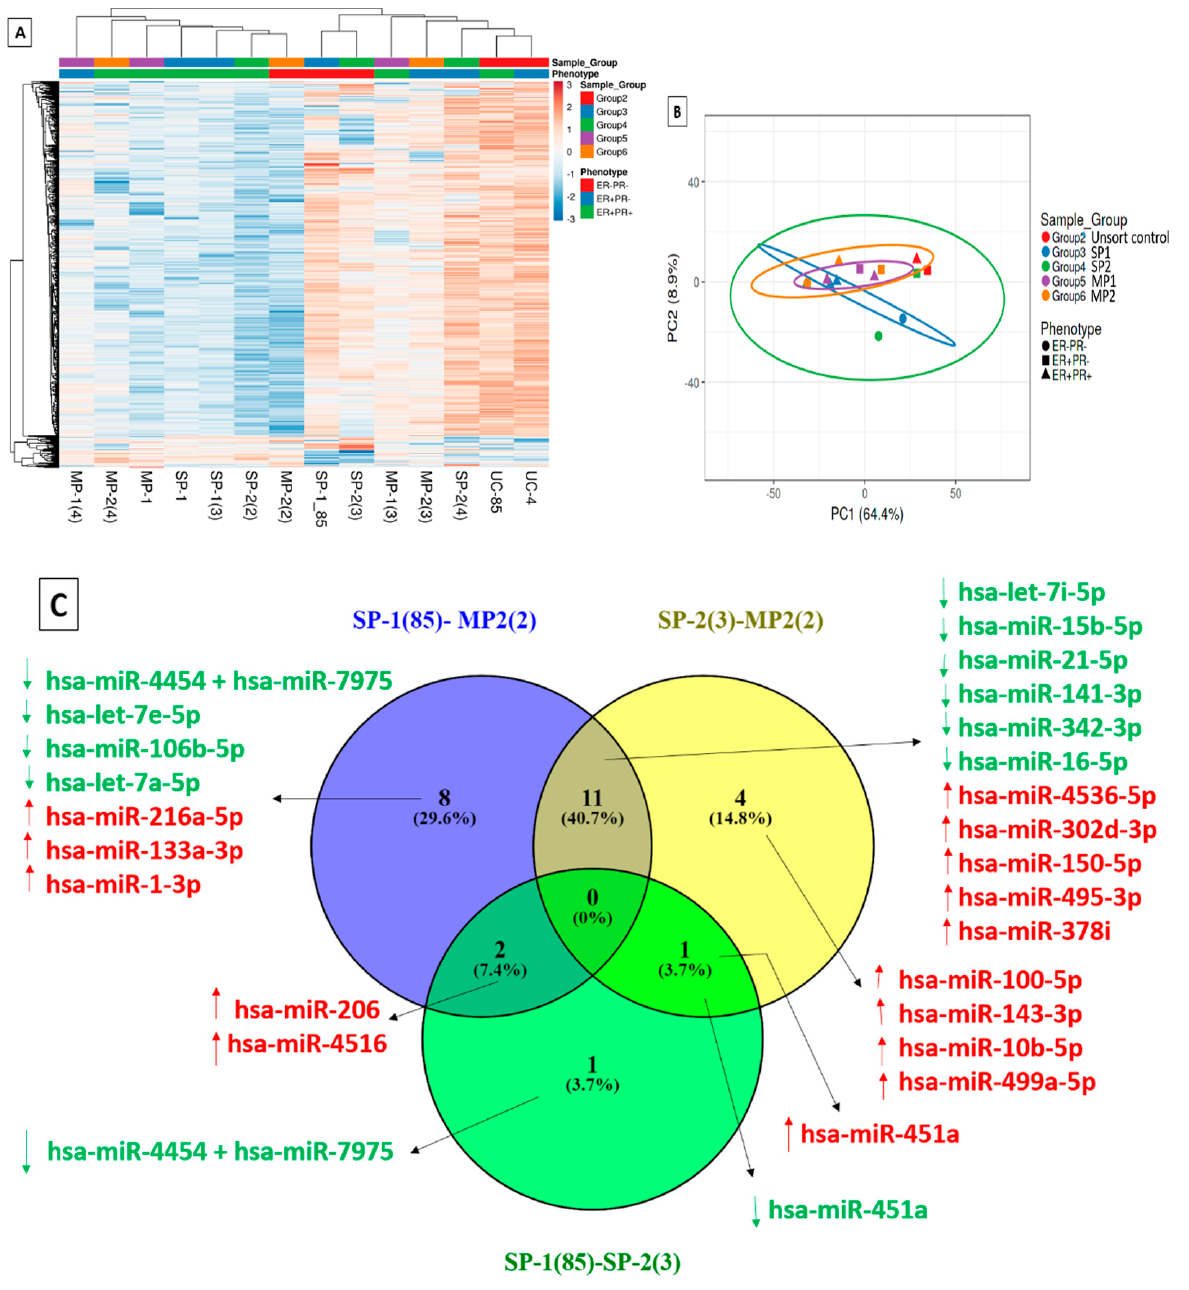
Figure 5. Heat map and PCA mapping of differentially expressed microRNAs. ( A ) MicroRNA array of various subtype phenotypes and a heatmap representation of the differentially expressed (DE) microRNAs. The samples were clustered into two main groups with significantly upregulated and downregulated sets of microRNAs across the fractions. ( B ) The principal component analysis (PCA) plot also grouped the samples broadly into 2 clusters. Samples of the phenotypes ‘ER − PR − ’ and ‘ER+ PR − ’ were observed to partially cluster together. ( C ) Differential microRNA profiling of ER − fractions in the MCF7 cell line. The differentially expressed miRNAs with significant fold changes ≥ 1.5 (upregulated) or ≤− 1.5 (downregulated) and counts ≥ 15.6 (average of negative control) in any of the samples (test or control) are marked as upregulated in red, while the downregulated miRNAs are marked in green. Abbreviations: hsa-miR, Homo sapiens (hsa) microRNA.